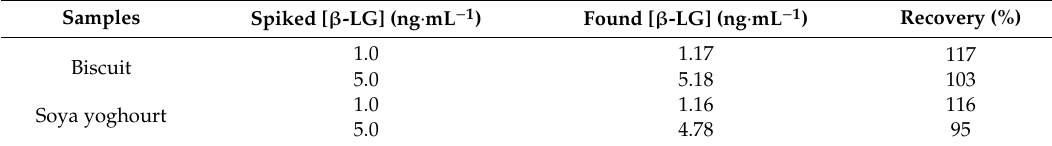
Table 2. Spike and recovery experiment data. Concentrations of 1.0 and 5.0 ng · mL − 1 of β -LG were spiked in biscuit and soya yoghourt samples (n = 3 for each). The recovery (%) was calculated comparing the concentration obtained with the samples with that obtained in PBS bu ff er, using the optimized